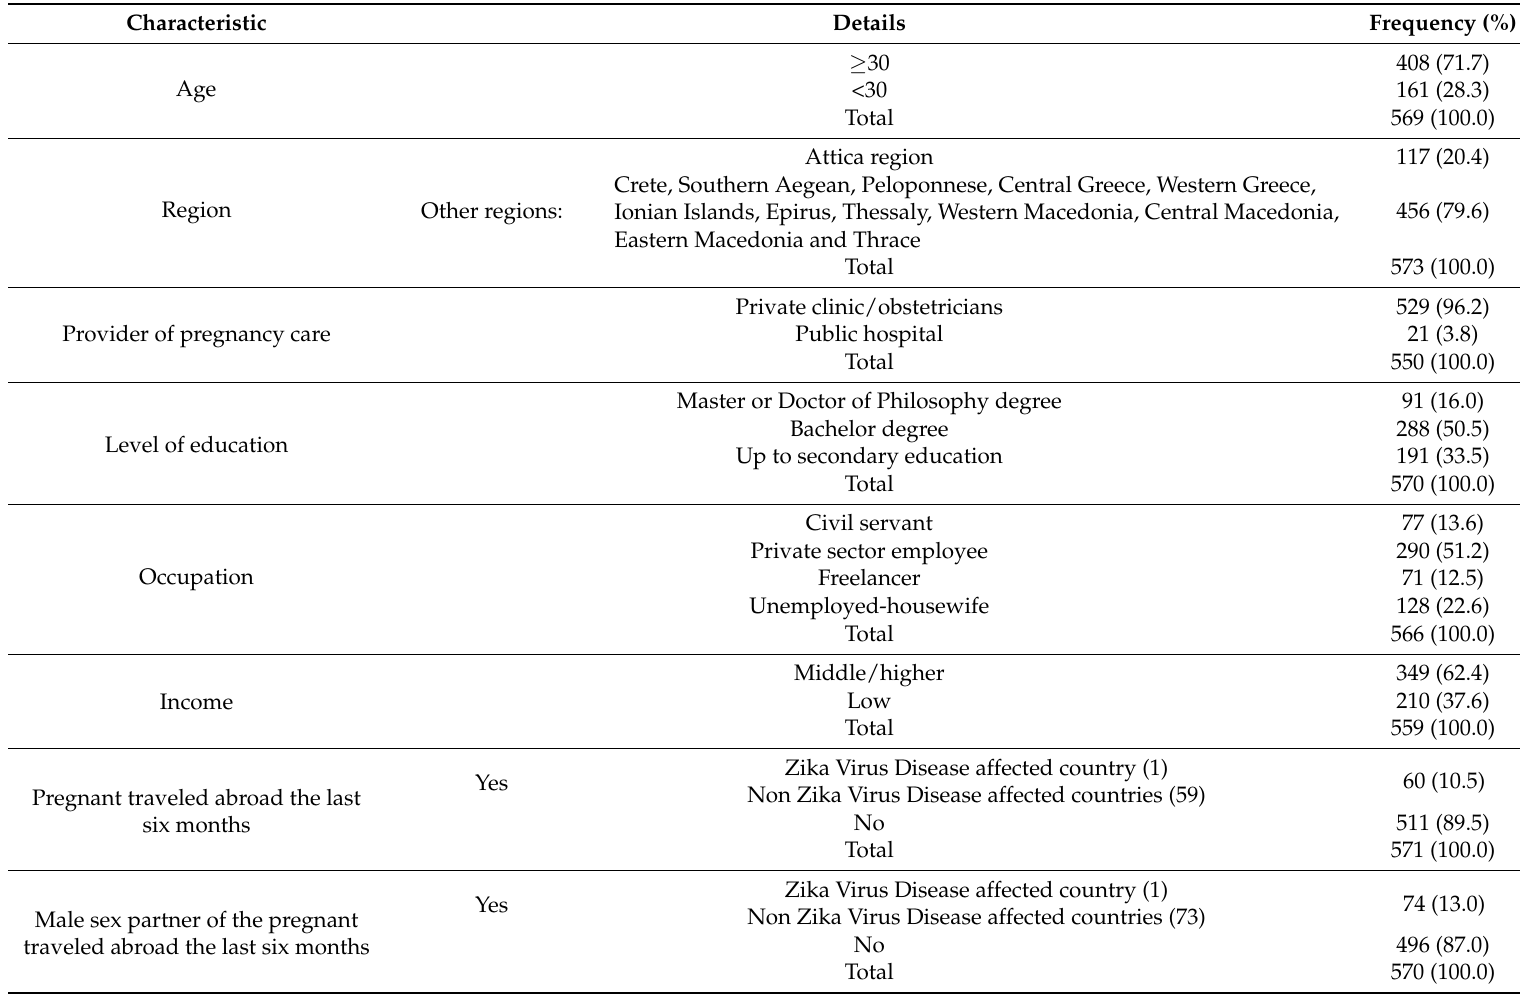
Table 1. Demographic characteristics and information about pregnant women and their male sex partners that have traveled